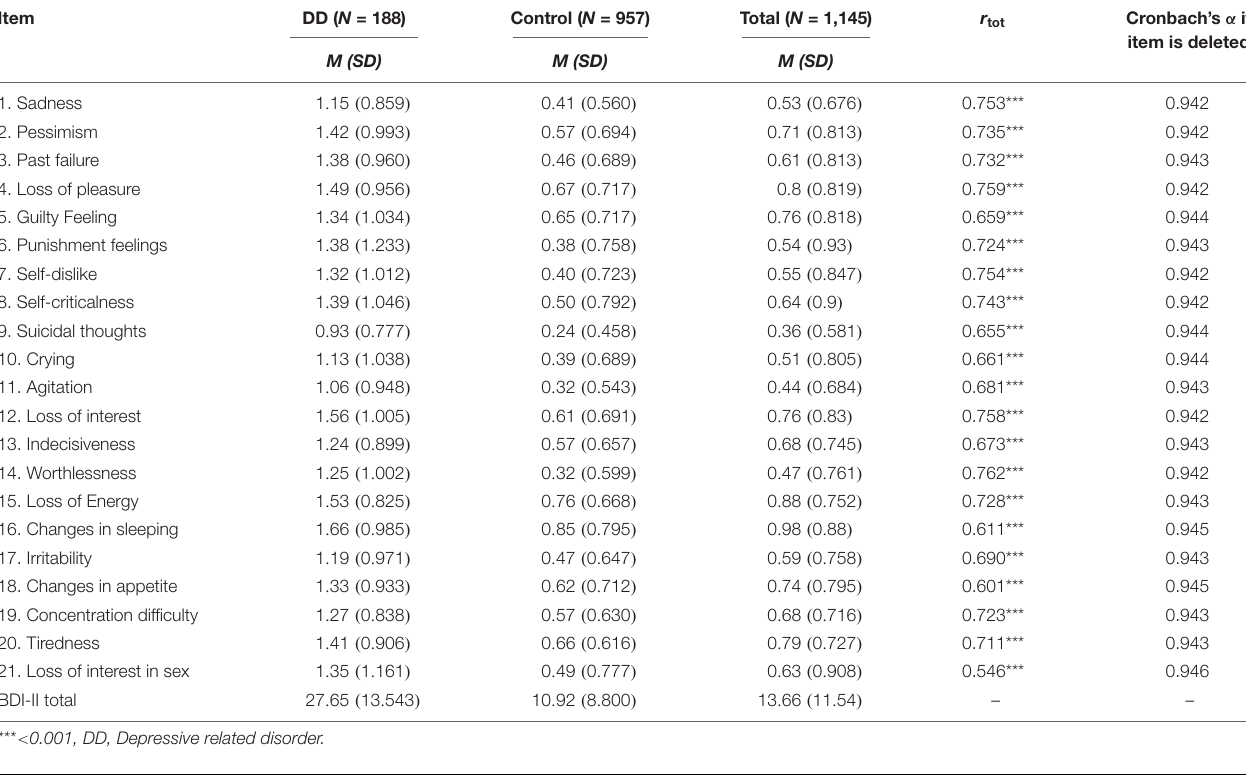
TABLE 2 | Mean, standard deviations, and item-total correlations of the Korean BDI-II . Item DD ( N = 188) Control ( N = 957) Total ( N = 1,145)